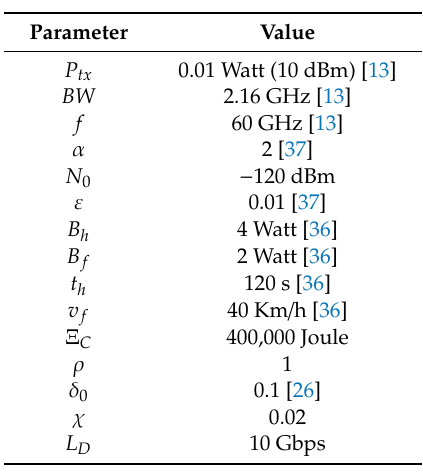
Table 1. Simulation